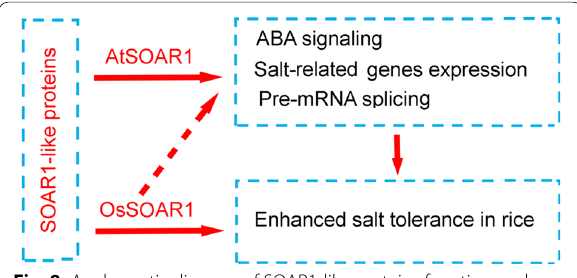
Fig. 8 A schematic diagram of SOAR1‑like proteins function under salt stress. SOAR1‑like proteins positively modulate plants response to salt stress through influencing ABA signaling, salt‑responsive genes expression and pre‑mRNA splicing. Solid lines indicate confirmed results and dotted lines indicate unconfirmed